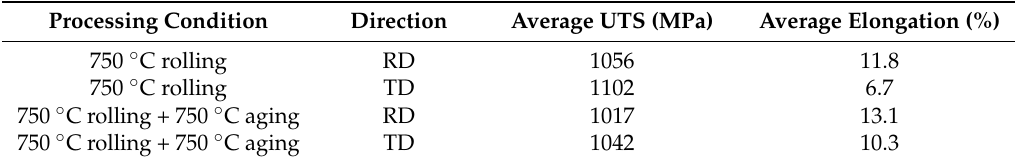
Table 1. Tensile properties of different samples.